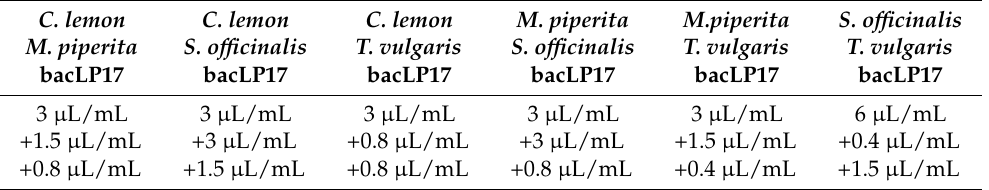
Table 4. MICs of the most advantageous EO/EO/bacLP17 combinations (chosen based on the FIC-Index) added to the